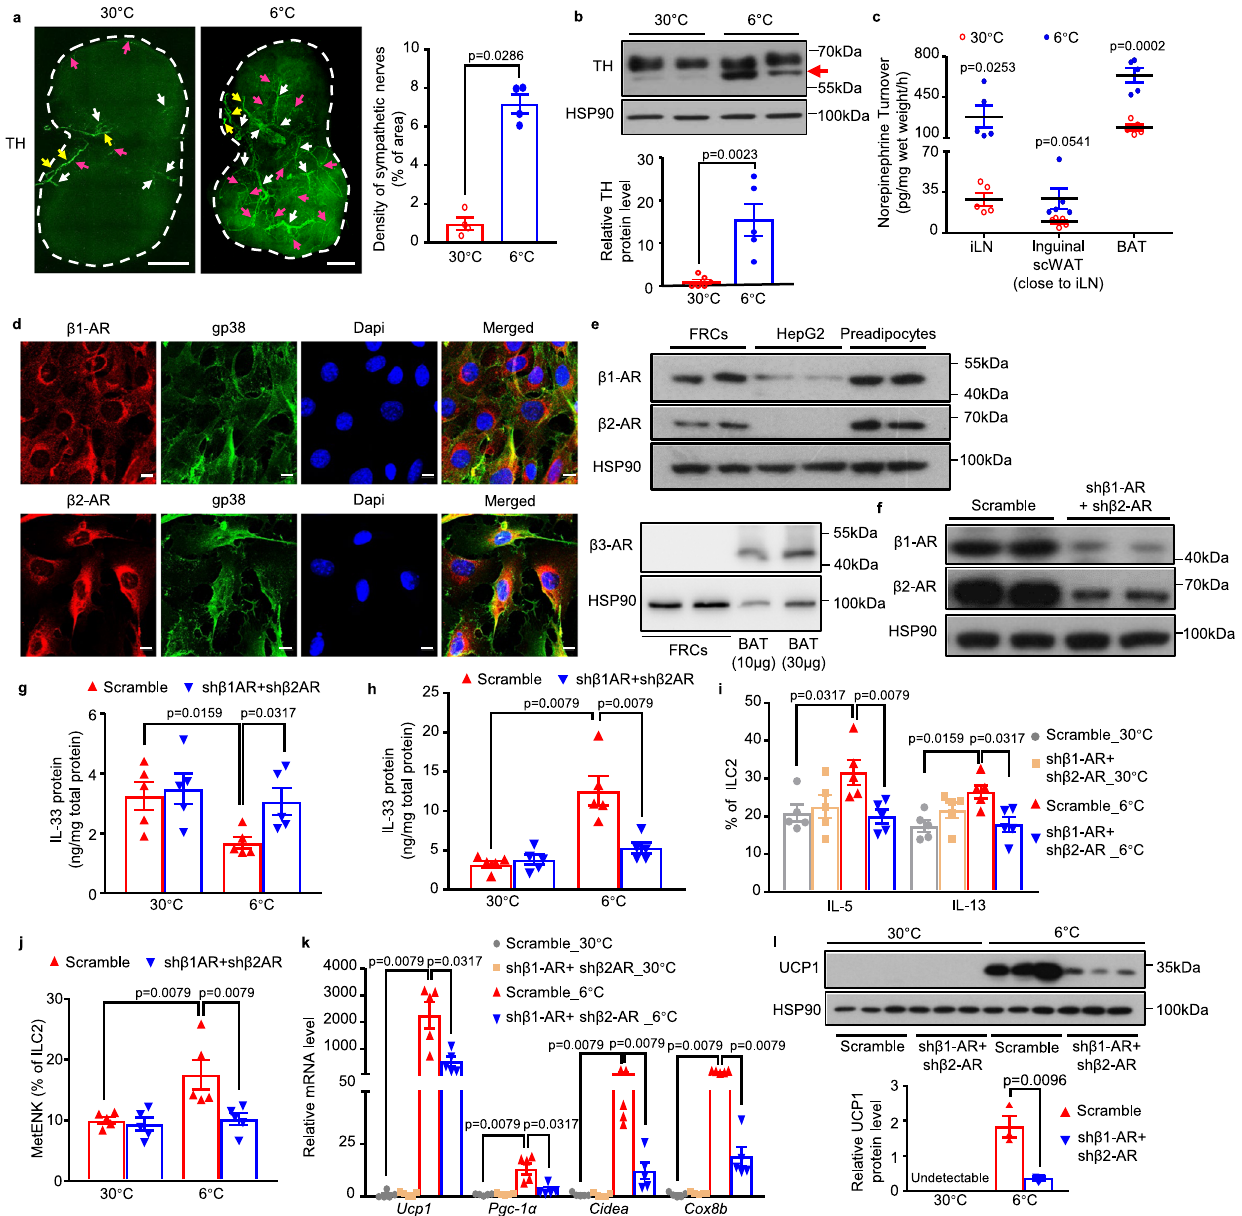
Fig. 5 | Cold exposure enhances sympathetic innervation of iLN and activates β 1-and β 2-ARsignalinginFRCstopromotethereleaseofIL-33.a – d Eight-week- old male C57BL/6N mice were housed at 30°C for three weeks before subjecting to exposure at 6°C or 30°C for 2 days. a Whole-mount imaging of tyrosine hydroxylase (TH, green) in iLNs (left). Arrowheads indicate distinct patterns of sympathetic innervation: (1) white arrows: along blood vessels; (2) yellow arrows: nerve bundles; (3) magenta arrows: neurite projections. Scale bar, 500 μ m. The quanti fi cation of TH-positive signal using ImageJ (right) ( n =4). b Western blot analysis for TH in iLN (top) and densitometric quanti fi cation of TH protein (bot- tom) ( n =6 for 30°C and n =5 for 6°C are from one experiment and processed in parallel). c Norepinephrine turnover (NETO) was determined by LC/MS analysis ( n =5). d Representative confocal images of cultured FRCsstained with antibodies againstadrenergicreceptors( β 1-ARor β 2-AR)andgp38;Scalebar,10 μ m. e Protein expression of β 1-AR, β 2-AR and β 3-AR in FRCs. HepG2, SVF-derived preadipocytes and BATwereused ascontrols ( n =2). f – l Lentiviruses encoding shRNAagainst β 1-